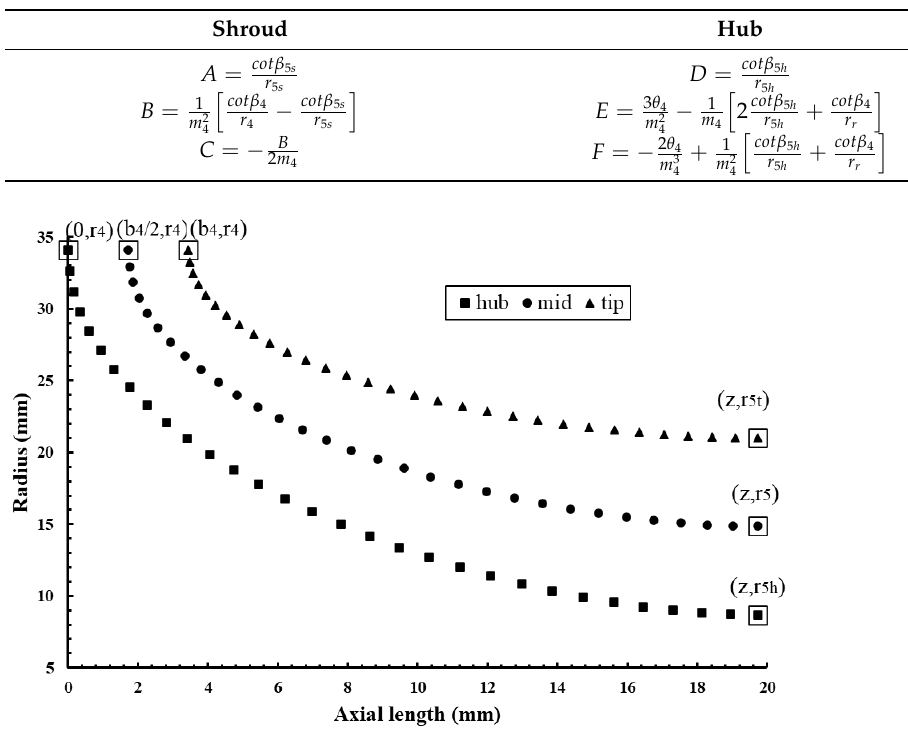
Table 3. Definitions of blade thickness coefficients.